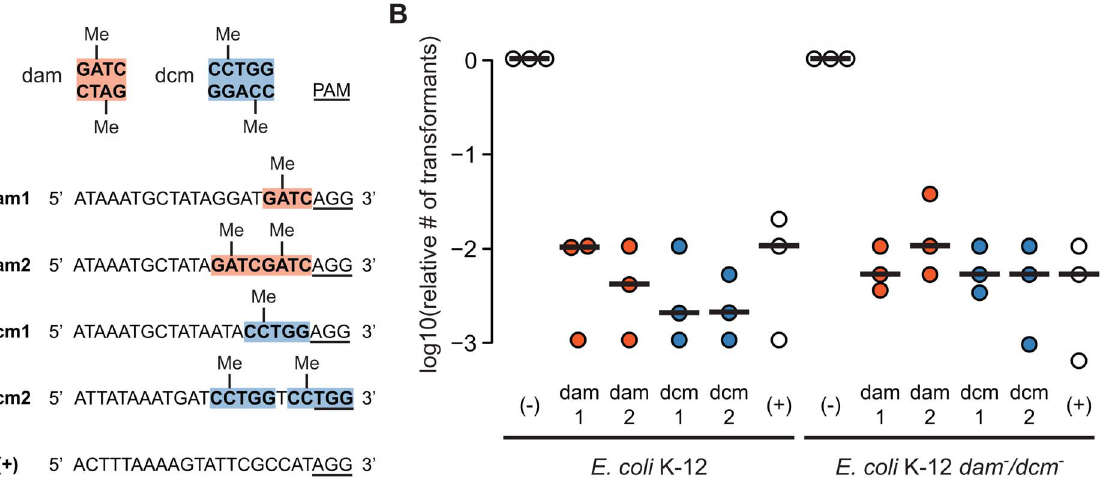
Figure 2. Cas9 cuts methylated cytosines and adenosines in E.coli . (A) Synthetic targets were designed to contain one to two dam (orange) or dcm (blue) sites. A control unmethylated sequence ( + ) was included. The PAM sequence NGG for SpCas9 recognition is underlined. (B) In serial transformations, we selected for the coexistence of DS-SPcas, the protospacer plasmid, and each spacer plasmid. The number of transformants was divided by the number of colonies resulting from a control transformation using a spacer plasmid (-) that did not target the protospacer plasmid. This relative number of transformants is plotted for E. coli K-12 and E. coli K-12 dam 2 /dcm 2 from three independent experiments. Lines represent the median.